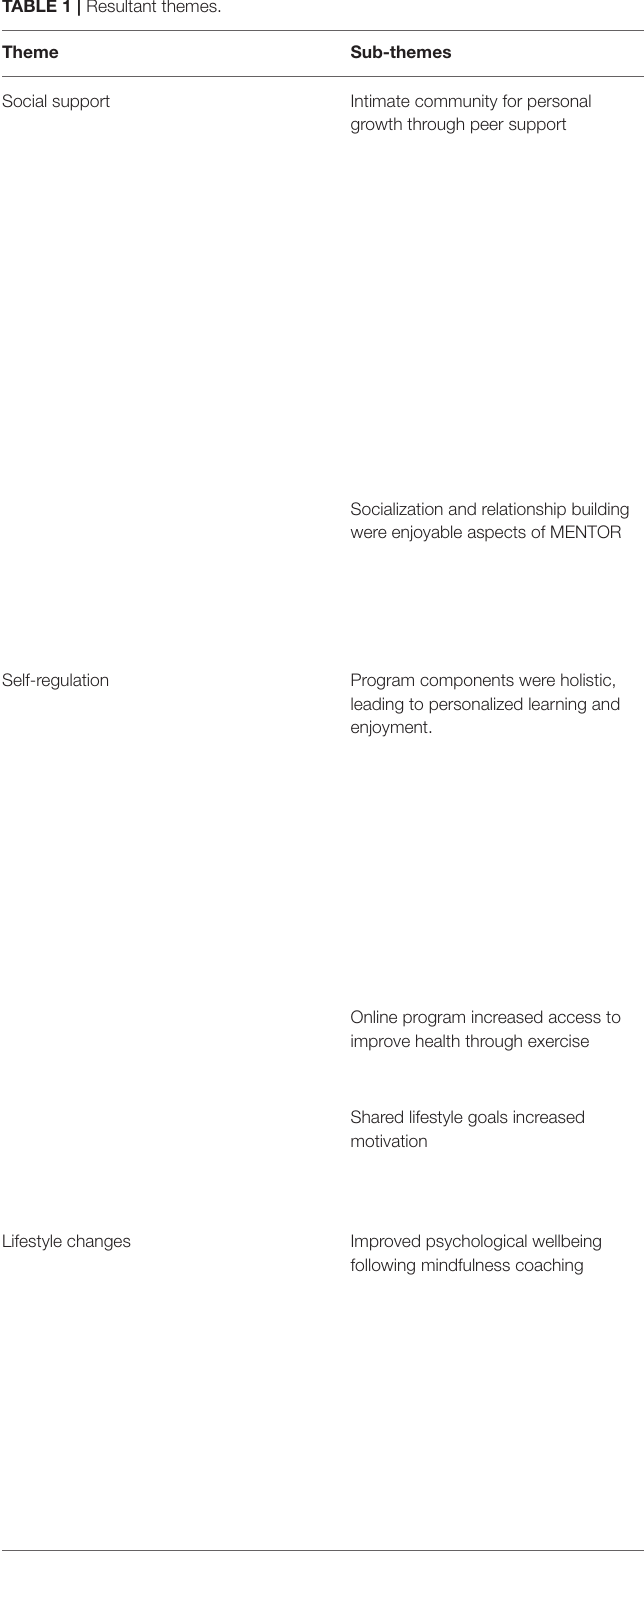
TABLE 1 | Resultant